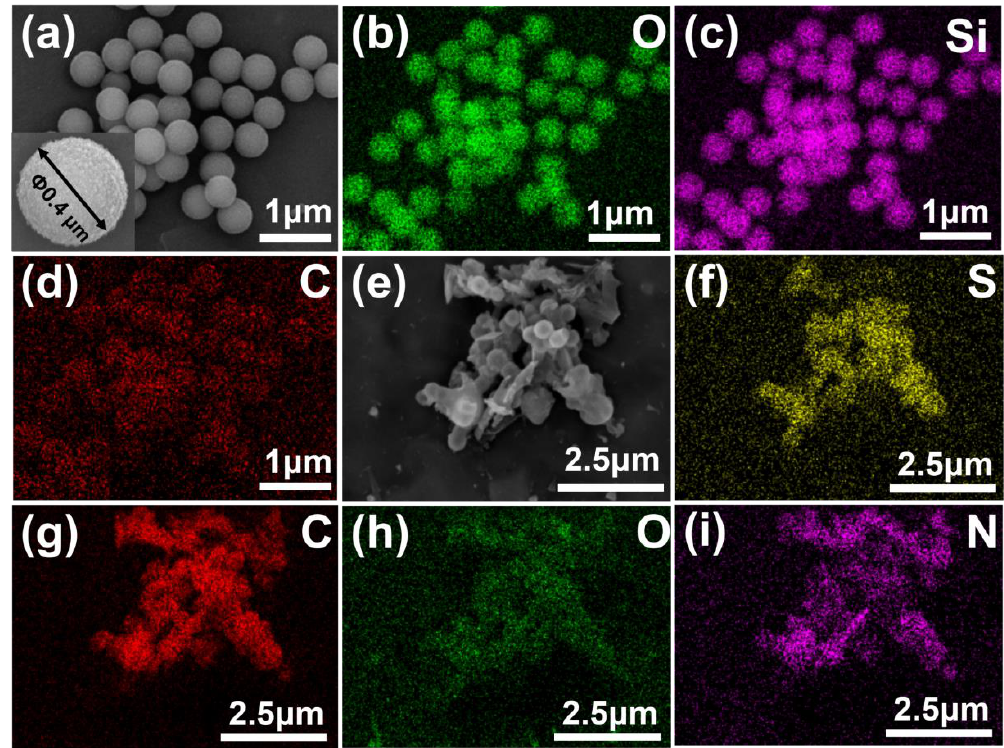
Figure 3. Elemental mapping images of SiO 2 ( a – d ) and HSPI-3 ( e – i ) composite sample.